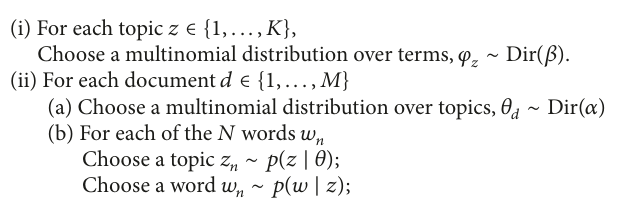
Algorithm 1: The generation process of LDA.